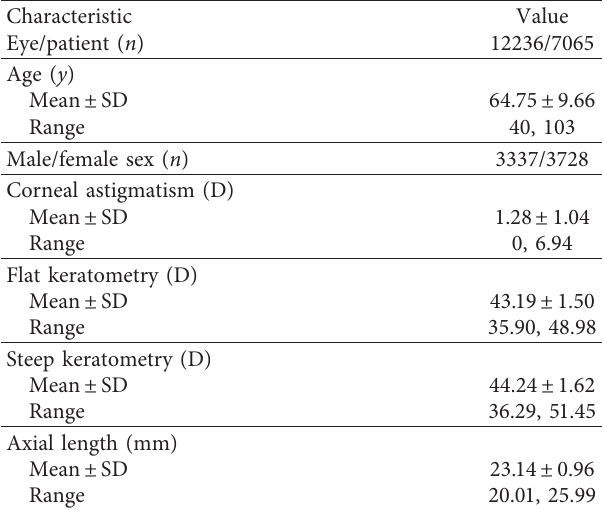
Table 1: Demographic and clinical characteristics of the ARC